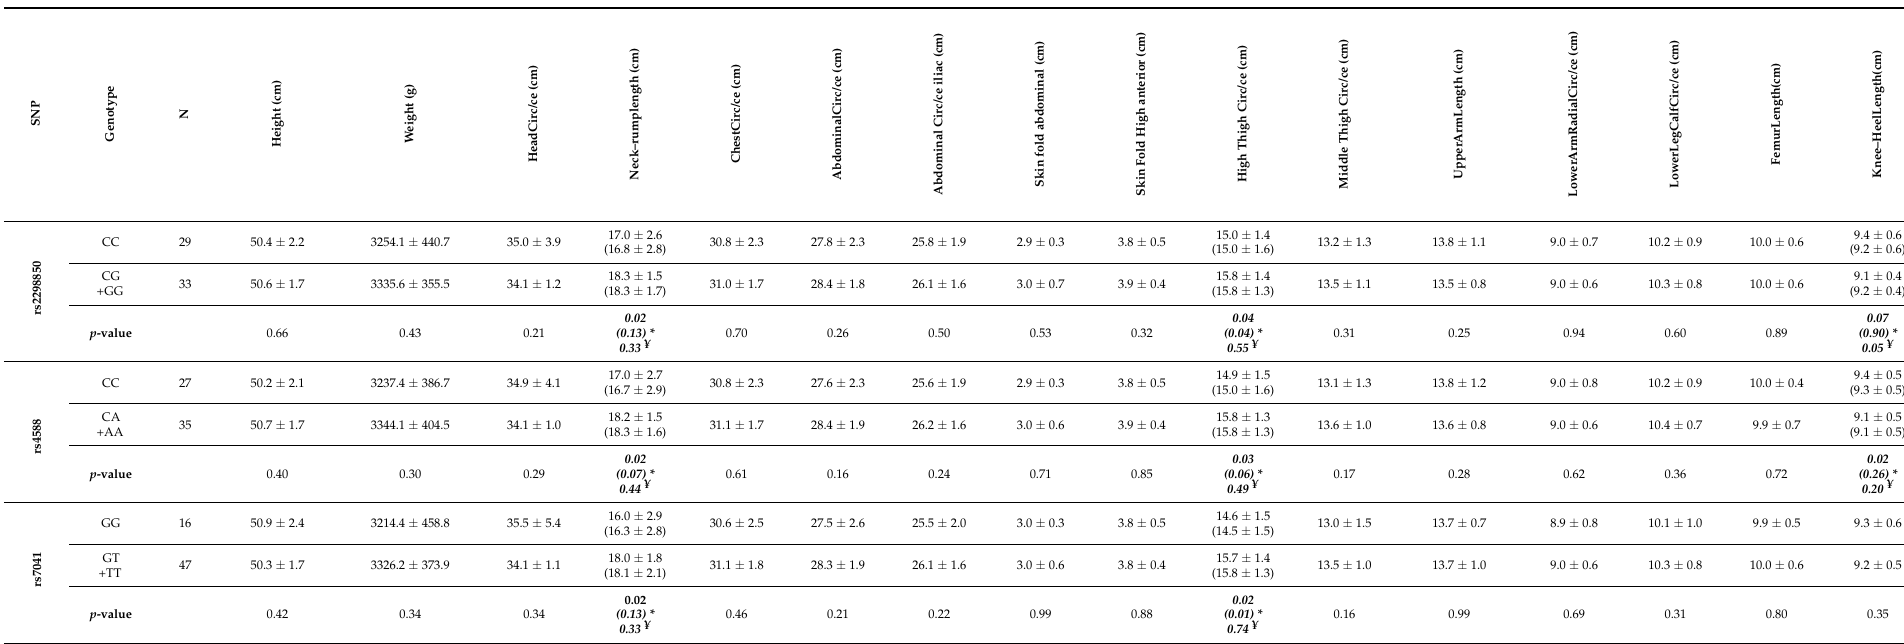
Table 7. Birth neonatal anthropometry (neonatal 25 (OH)D ≤ 75 nmol/L) according to neonatal VDBP polymorphisms . If Levene’s Test for Equality of Variances p > 0.05 then Equal variances assumed Sig (2-tailed) p -values of T-Tests were given. If Levene’s Test for Equality of Variances p < 0.05 then Equal variances not assumed Sig (2-tailed) p -values of T-Tests were given. * The data and p -values adjusted for maternal height (cm), BMI pre-pregnancy (kg/m 2 ), BMI terminal (kg/m 2 ), and weeks of gestation by One-way analysis of covariance (ANCOVA) Numbers in italics are after adjustments. ¥ Observed power